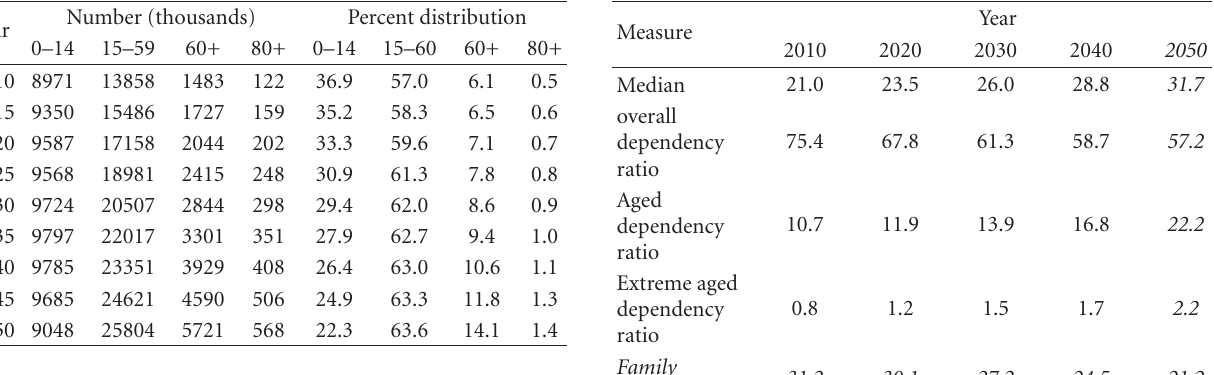
Table 5: Future structure of Ghana’s population, 2010–2050. Table 6: Measures of population aging in Ghana: 2010–2050.